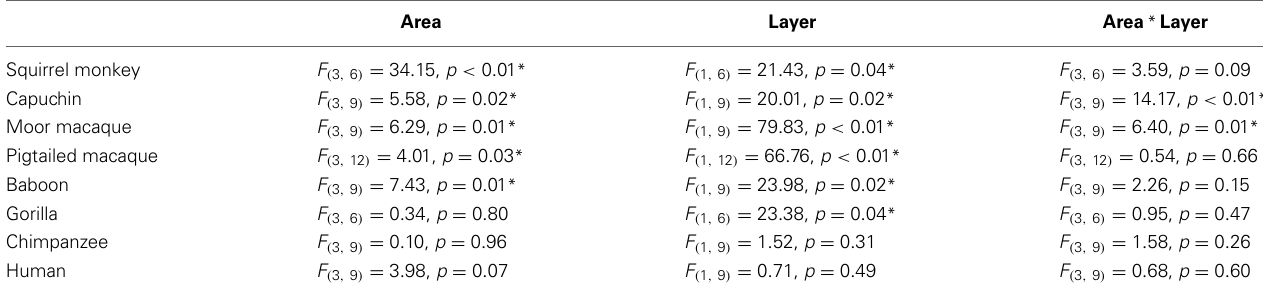
Table 2 | Summary of main effects (area and layer) and interaction term for the within-species repeated-measures ANOVA for varicosity